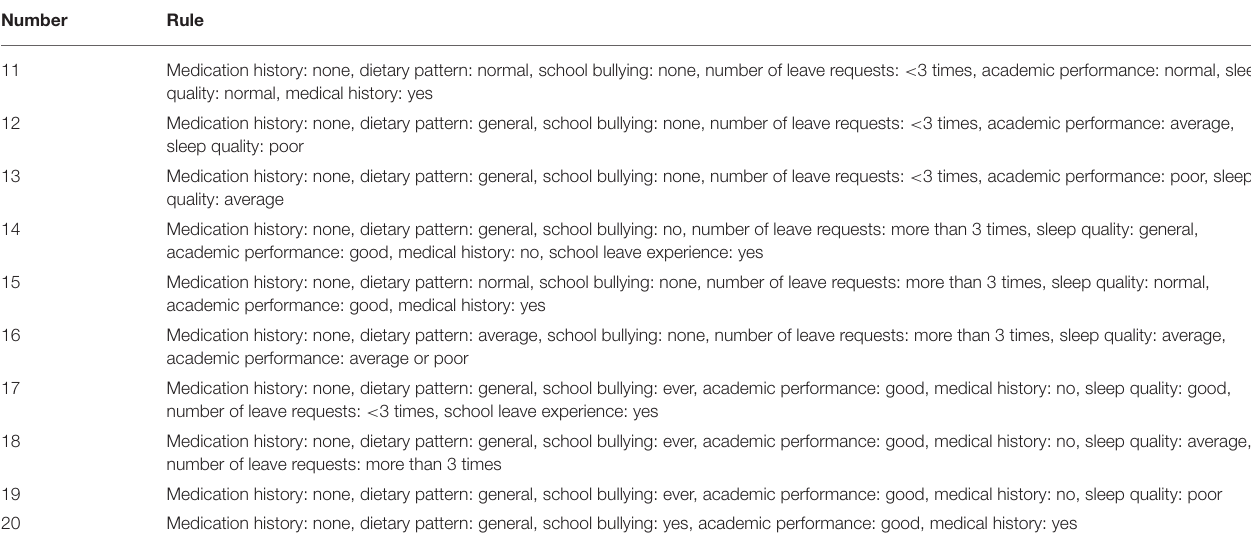
TABLE 5 | Psychological crisis judgment Table 2